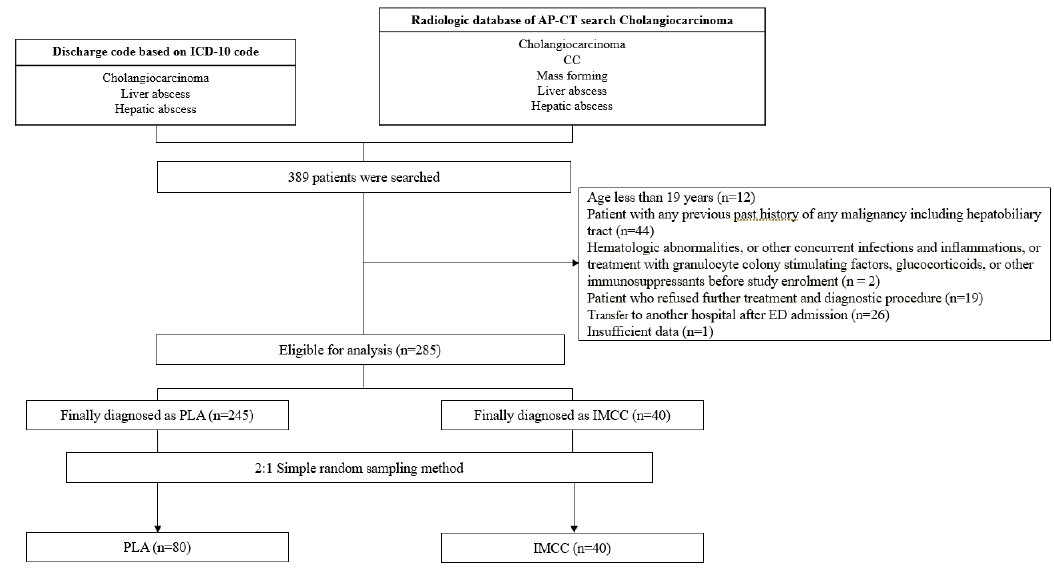
Figure 1. Patient flow of patients with LA and IMCC for analysis. *LA: pyogenic liver abscess; IMCC: intrahepatic mass-forming cholangiocarcinoma; ICD-10: International Classification of Diseases, tenth revision; AP-CT: abdominal pelvic computed tomography.